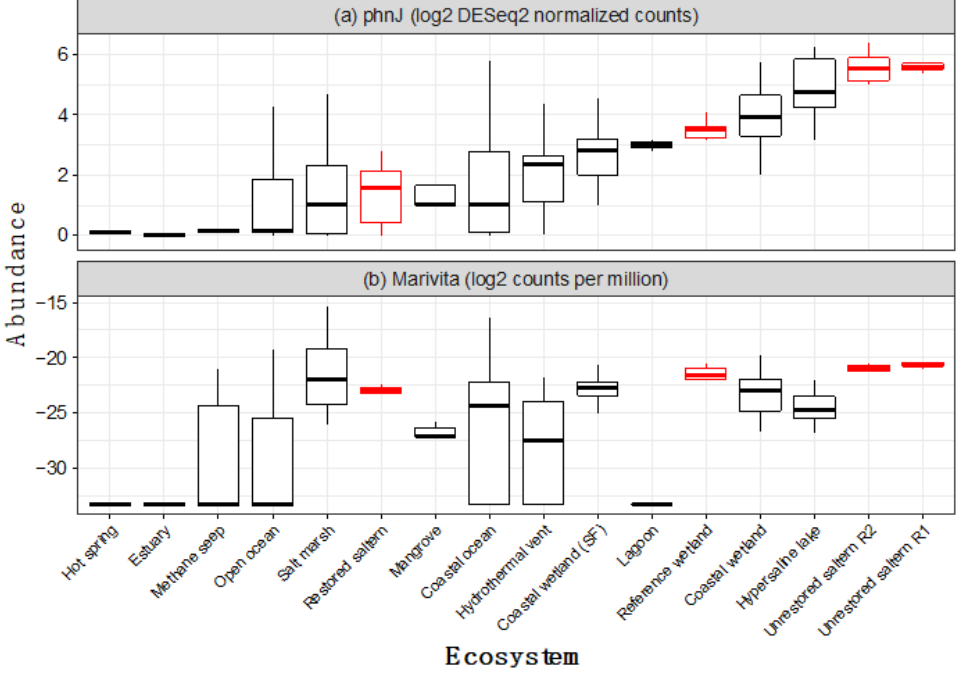
Figure 4’s box-and-whisker plot was originally intended to show raw data points. These points were unfortunately lost.